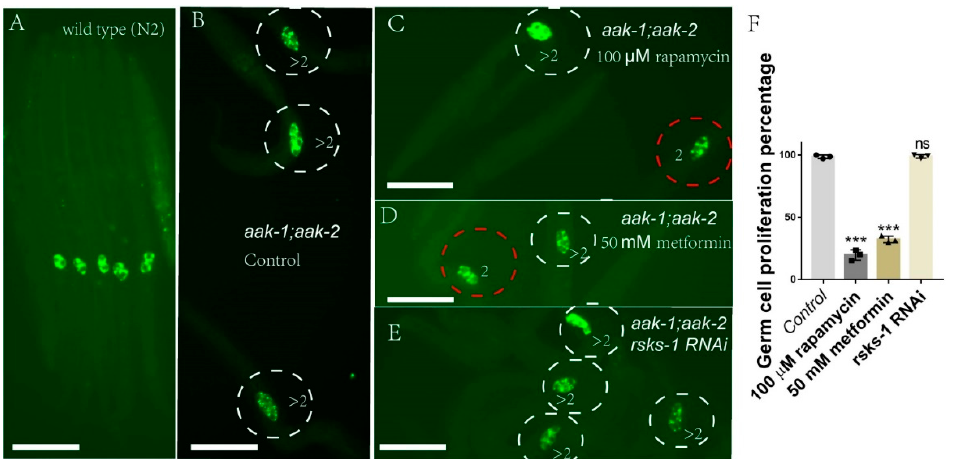
Figure 3. Metformin can suppress germ-cell proliferation during L1 arrest through S6K independent mTOR. Germ-cell-specific antibody (anti-PGL-1) staining. ( A ) Wild-type worms only show two germ cells during L1 arrest. ( B ) aak-1(tm1944) ; aak-2(ok524) double mutants serve as a control and these worms show 100% germ cell proliferation during L1 arrest. aak-1(tm1944) ; aak-2(ok524) double mutants treated with rapamycin ( C ), metformin ( D ), or rsks-1 RNAi ( E ). Rapamycin and metformin can suppress germ cell proliferation, while rsks-1 RNAi has no effect on germ-cell proliferation ( F ). Data are the average of three independent experiments. The sample size in each experiment is larger than 80 worms. Error bars: standard deviation (SD). ***: p < 0.001. Scale bars: 50 μ m.